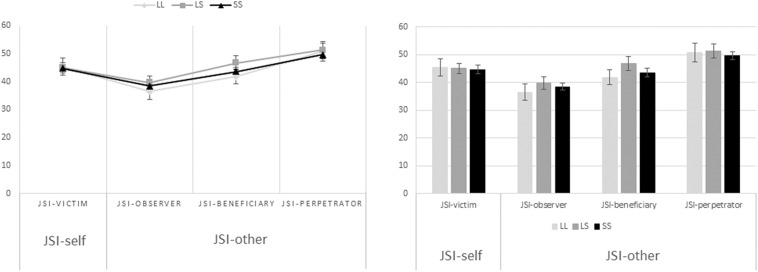
Association between the 5-HTTLPR genotype groups and self-oriented and other-oriented justice sensitivity. In the one-way ANOVA performed to assess the relationship between the serotonin transporter genotype groups (L/L, L/S, S/S), and self-oriented (46 ± 2.95, 46 ± 1.62, 44.6 ± 1.36, mean ± SE, respectively) and other-oriented (43.5 ± 2.51, 46 ± 1.80, 44.6 ± 1.05, mean ± SE, respectively) justice sensitivity, the results yielded no significant differences between group means neither when it comes to self-oriented [F(2,111) = 0.245, p = 0.783], nor when it comes to other-oriented justice sensitivity [F(2,111) = 0.399, p = 0.672]. In the same manner, the MANCOVA performed to assess the same relationship but controlling for age and gender was also non-significant [F(4,216) = 0.391, p = 0.815, Wilks’ Λ = 0.986, ηp2 = 0.007].